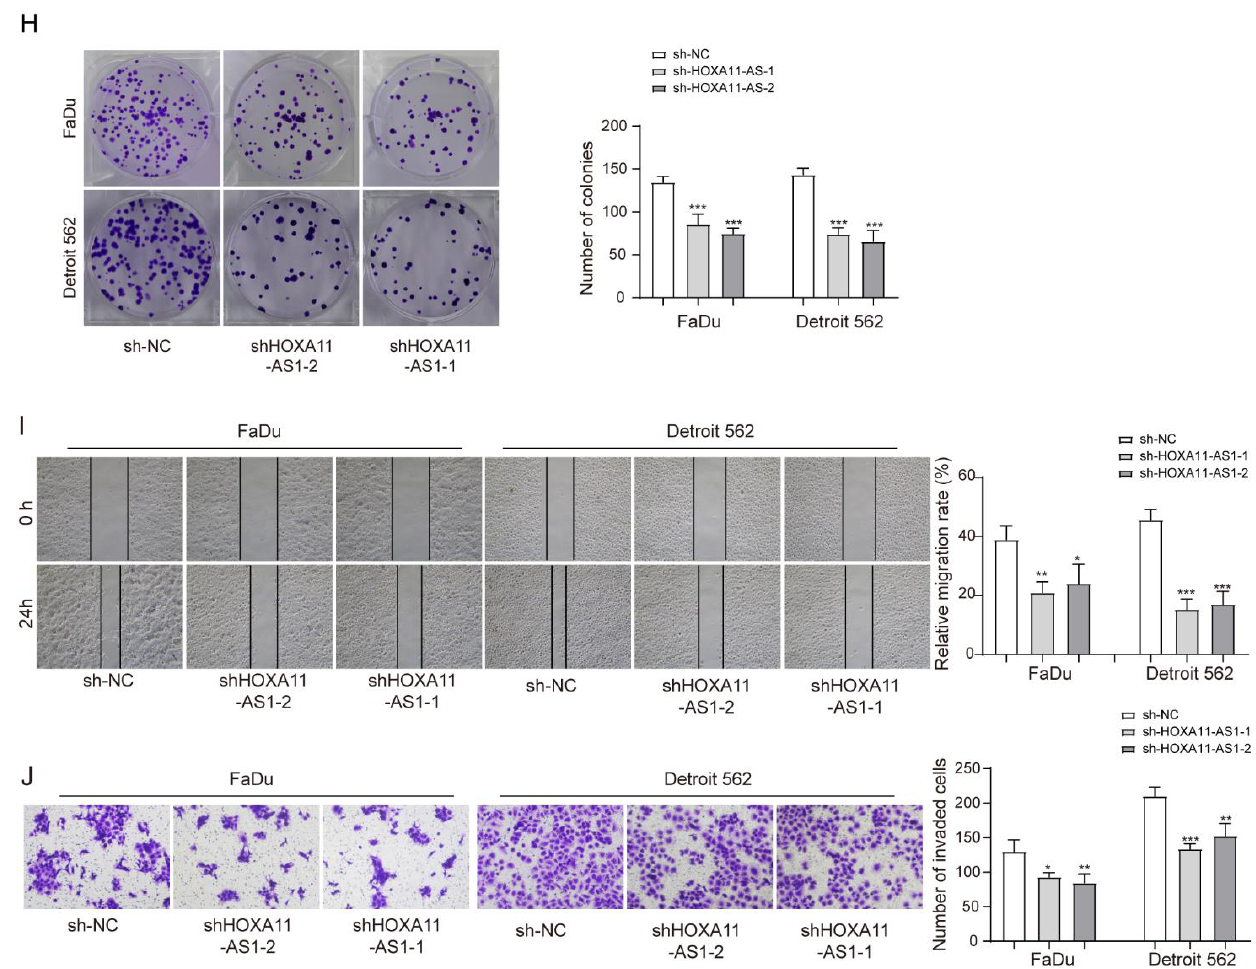
Figure 2. HOXA11-AS1 knockdown suppressed PD-L1 expression and immune escape, proliferation, and metastasis of HSCC cells. FaDu and Detroit cells were transfected with two specific shRNAs, shHOXA11-AS1-1 and shHOXA11-AS1-2. ( A ) Transfection efficiencies were measured by RT-qPCR. ( B , C ) PD-L1 levels were detected after silencing HOXA11-AS1 by Western blot and immunofluorescence. Anti-PD-L1 antibodies restored the cytotoxic effect of T lymphocytes. Treated FaDu and Detroit cells were pretreated with or without anti-PD-L1 antibodies for 1 h and co-cultured with PBMCs for 72 h (Representative images (400 × ) are shown, bars = 100 µ m.), then ( D ) the percentage of CD8 + and ( E ) CD4 + T cells was analyzed by flow cytometry, and ( F ) the concentration of IFN- γ was measured by enzyme-linked immunosorbent assay (ELISA). Viability, colony formation, migration, and invasion of FaDu and Detroit cells were measured by ( G ) CCK-8, ( H ) colony formation, ( I ) wound healing, and ( J ) transwell assays after knockdown of HOXA11-AS1. Representative images (200×) are shown. * p < 0.05, ** p < 0.01, *** p < 0.001. Original Blots see Supplementary File Figure S1.